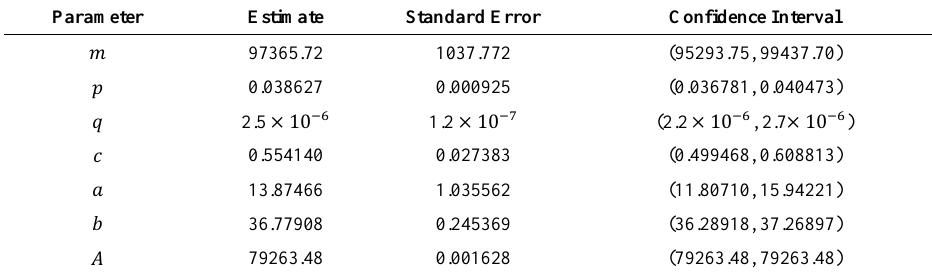
Table A9. Lombardy. Estimates, asymptotic standard errors and 95% mCIs for the parameters of the BeGBM 𝑹𝑬𝑪𝑻 (7)+(5). Parameter